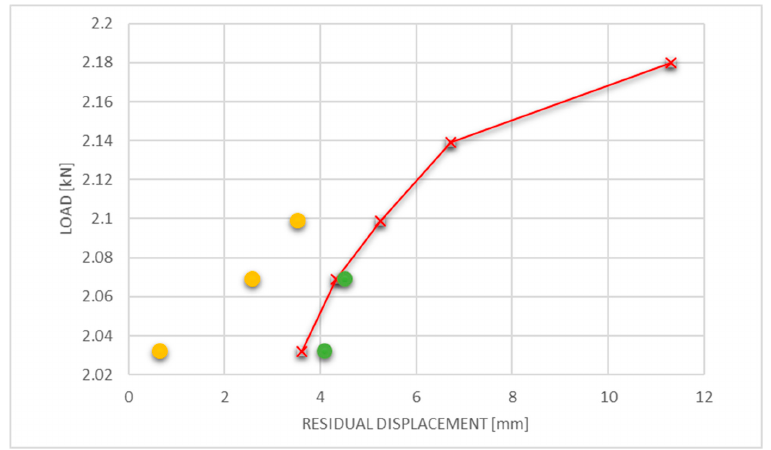
Figure 7. Figure 7 represents the load-displacement experimental curve, where the calculated displacement upper bound has been reported.